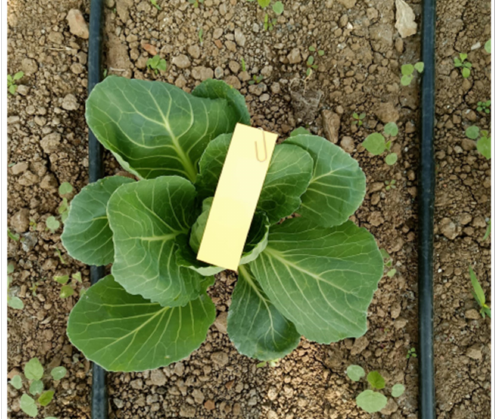
Figure 10. Placement of water-sensitive